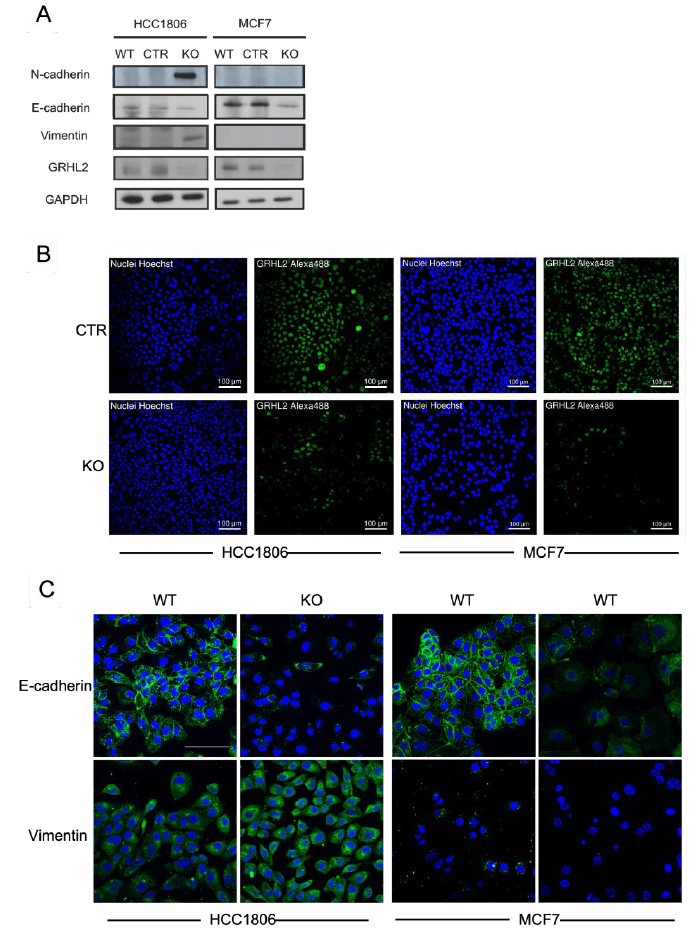
Figure 6. Regulation of EMT related genes by GRHL2. ( A ) Western blot analysis of the indicated proteins in wild type (WT) and sgCTR (CTR) and sgGRHL2 transduced (KO) MCF7 and HCC1806 cells after 10 days doxycycline-induction. ( B ) Immunofluorescence analysis of HOECHST (nuclei, blue) and GRHL2 in MCF7 and HCC1806 cells expressing control sgRNA or GRHL2 sgRNA. ( C ) Immunofluorescence analysis of HOECHST (nuclei, blue), E-cadherin and Vimentin (Alexa-488, green), and F-actin (Rhodamine-Phalloidin, red) in WT, CTR, and KO MCF7 and HCC1806 cells after 10 days doxycycline-induction. Scale bar, 100 µm.